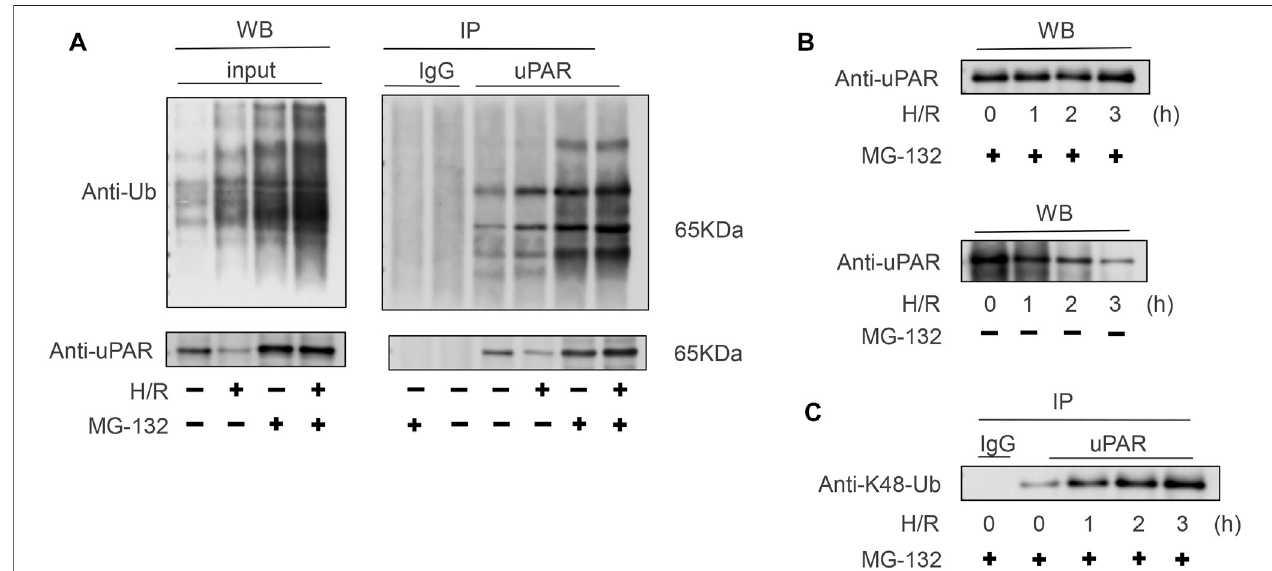
FIGURE5| PolyubiquitinationofuPARoccurs via lysine48-linkedchains. (A) LysatesobtainedfromBEAS-2B cellssubjectedwithorwithoutH/R±MG-132 were immunoprecipitatedusingananti-uPARantibody.Tocon fi rmsuccessfulubiquitination,blotswereprobedwithananti-Ubantibodytodeterminepoly-ubiquitinationand anti-uPARantibodies. (B) BEAS-2BcellssubjectedtoH/RforindicatedtimepointsunderwentMG-132;westernblottingwasdonewithanti-uPAR. (C) Sameas (B) ,but the lysates were immunoprecipitated using anti-uPAR and detected withanti-lysine 48K-Ub. Shown arerepresentative blots from three independent experiments. The results showed that uPAR is poly-ubiquitinated via lysine 48-linked chains in BEAS-2B cells subjected to H/R.